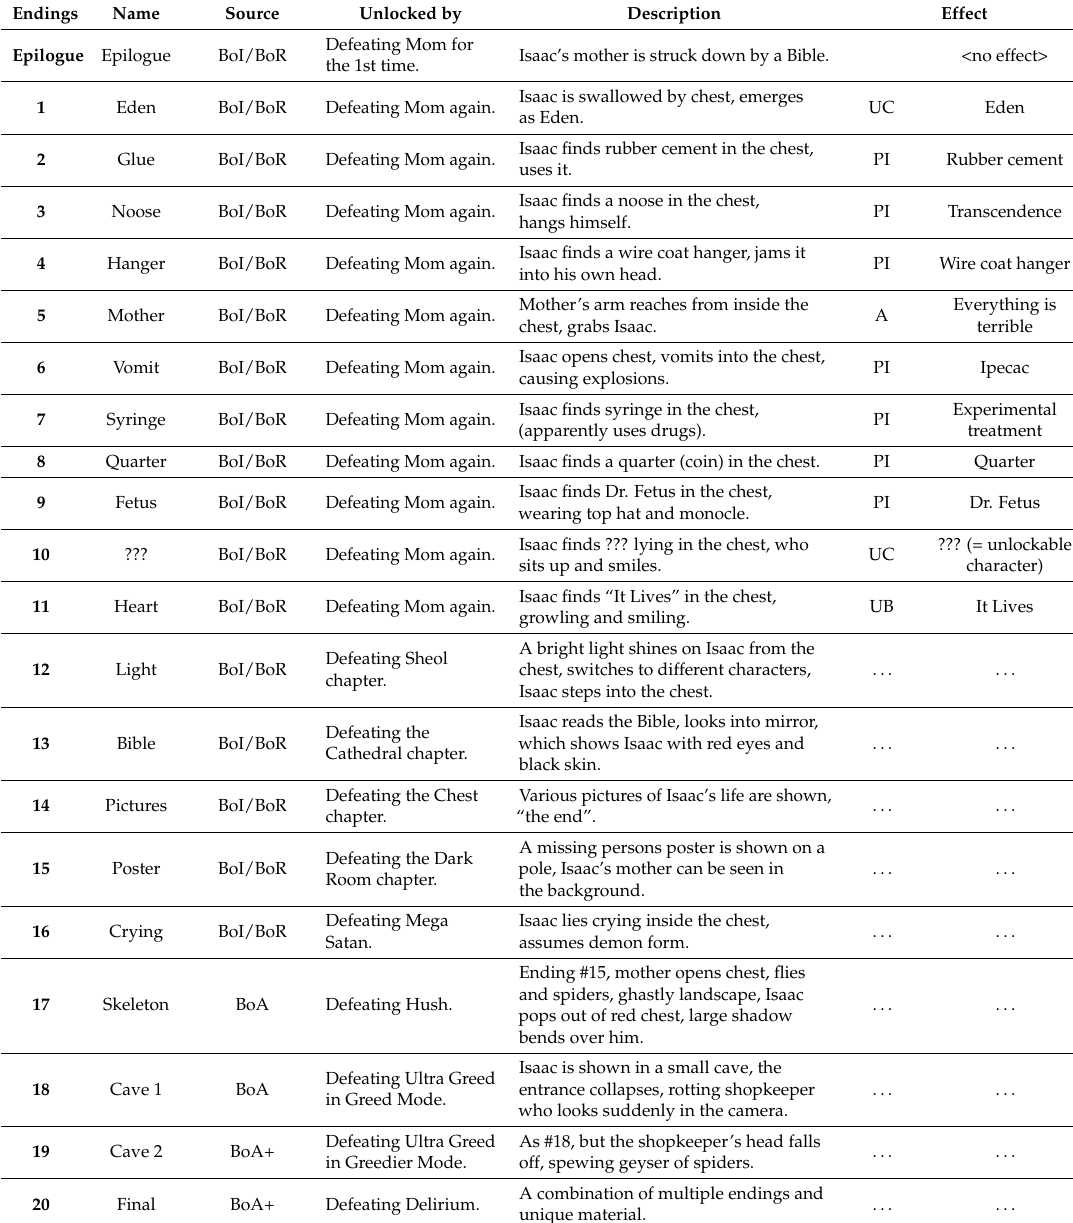
Table 3. Various endings of The Binding of Isaac